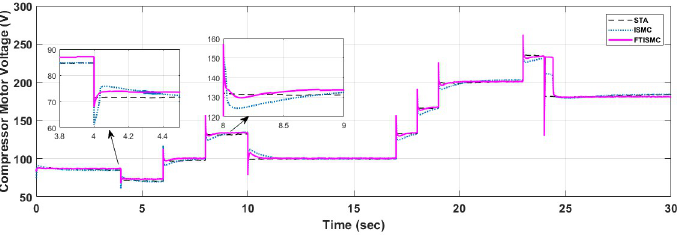
Fig 11. Compressor motor voltage.